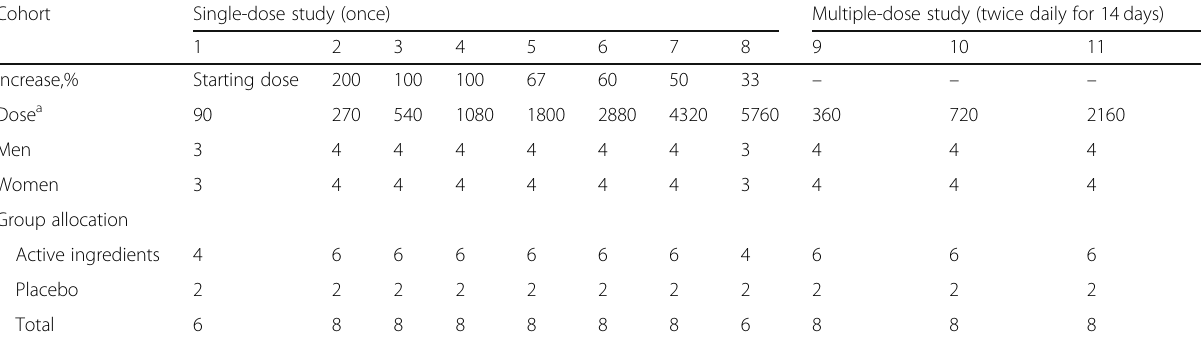
Table 1 Study design and subject allocation